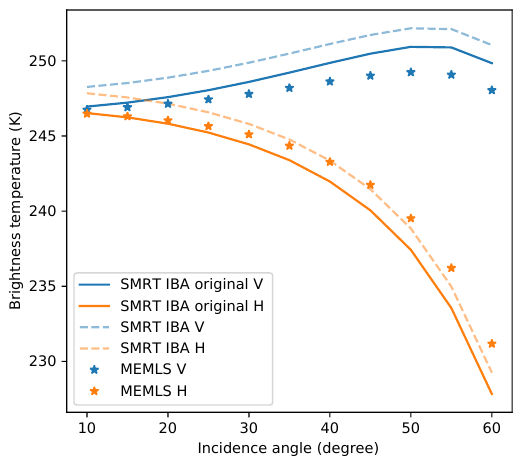
Figure 6. Comparison of brightness temperatures simulated by SMRT IBA with an exponential autocorrelation function and MEMLS. The correlation length is 100µm; other parameters are similar to those of Fig.